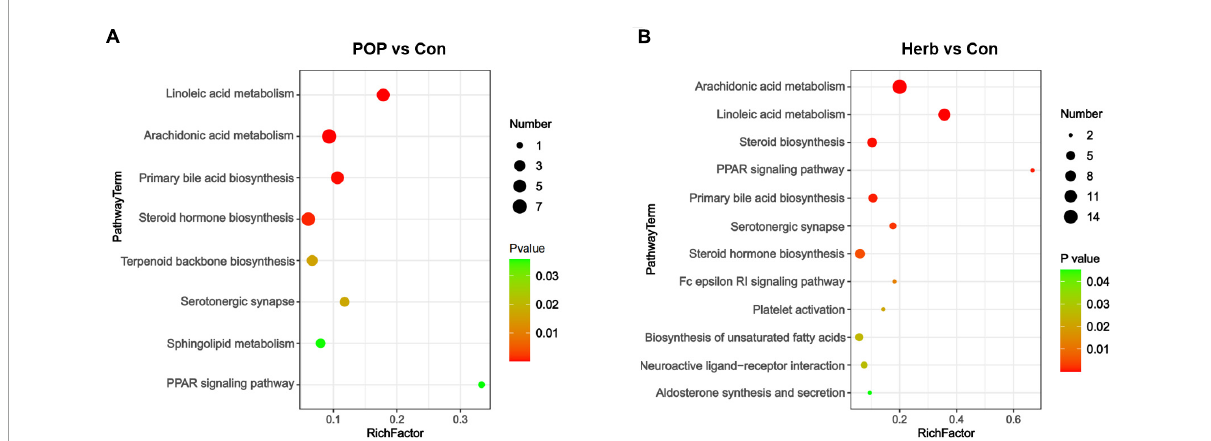
platelet activation, biosynthesis of unsaturated fatty acids, neuroactive ligand-receptor interaction, and aldosterone synthesis and secretion ( Figure 7B